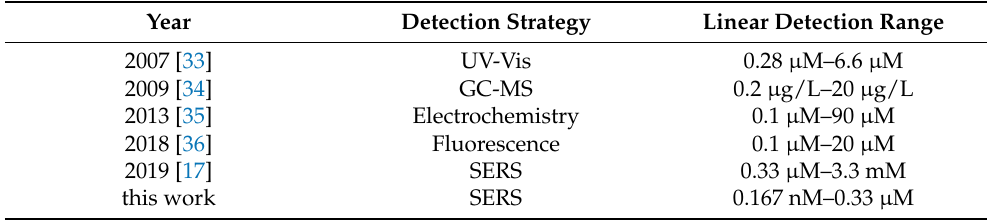
Table 1. Five MDA detection methods reported in recent